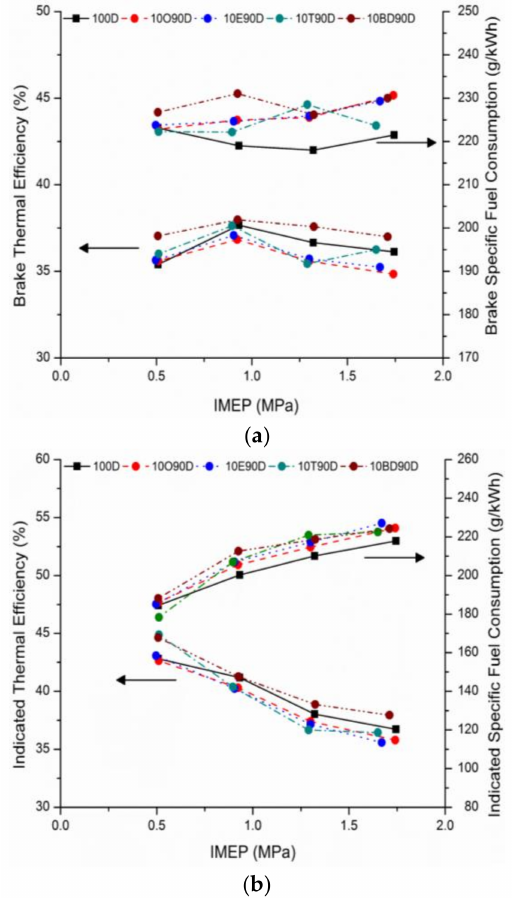
Figure 5. Thermal efficiency and fuel consumption variation of tested fuel blends: ( a ) Brake; and, ( b )